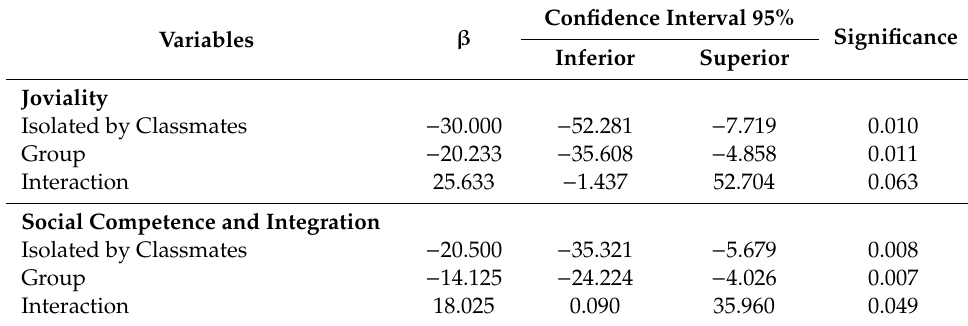
Table 7. Interaction of “Isolated by classmates” with Group on Social Competence and Integration, and Joviality. FXS = Fragile X Syndrome. CG = control group (central tendency and variability).